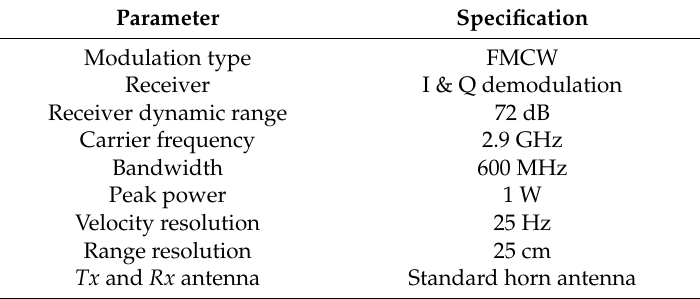
Table 1. Summary of System